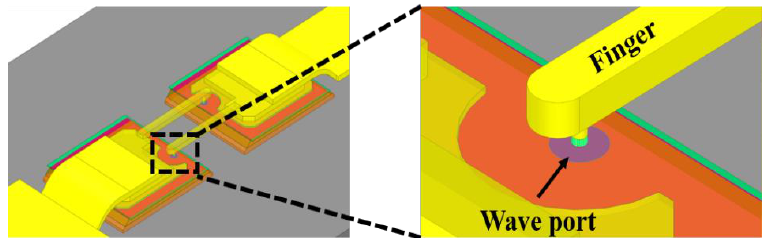
Figure 6. 3D diode chip model and diode port configuration in HFSS.